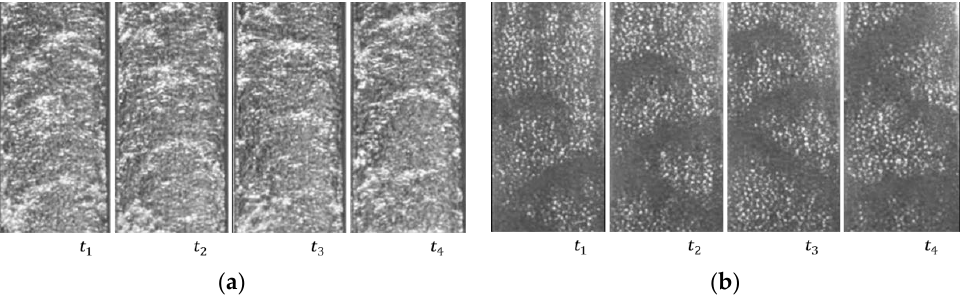
Figure 5. Flow patterns observed from the plain rectangular channel ( a ) and the copper porous media filled channel ( b ) at mean vapor quality are ( a ) = 0.48, ( b ) =